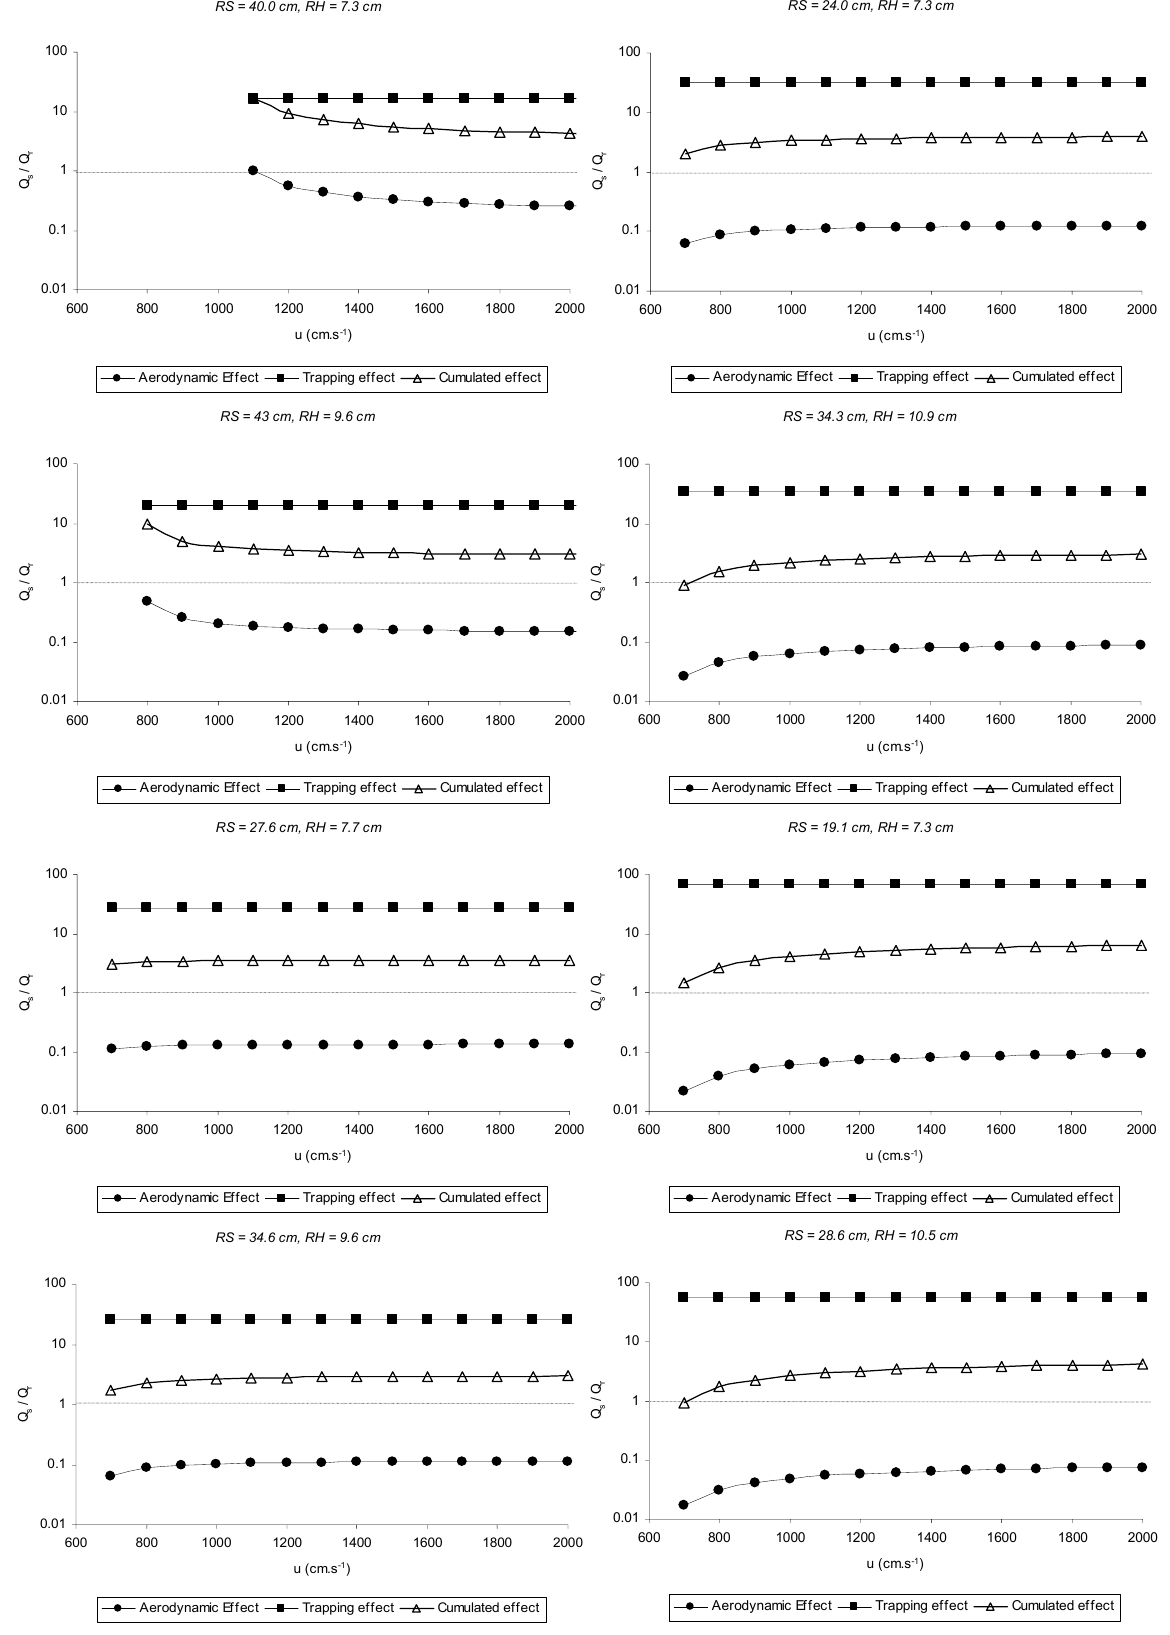
Fig. 14. Geometric and aerodynamic effects on horizontal flux reduction over ridged